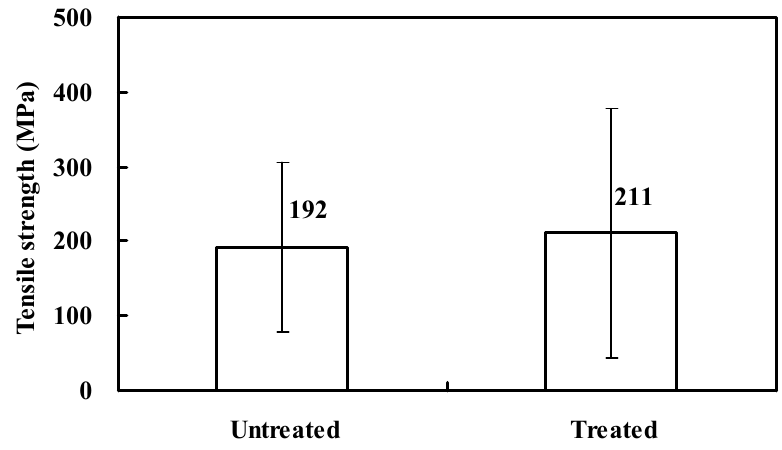
Figure 8. Tensile strength of bamboo fibers before and after alkali treatment.